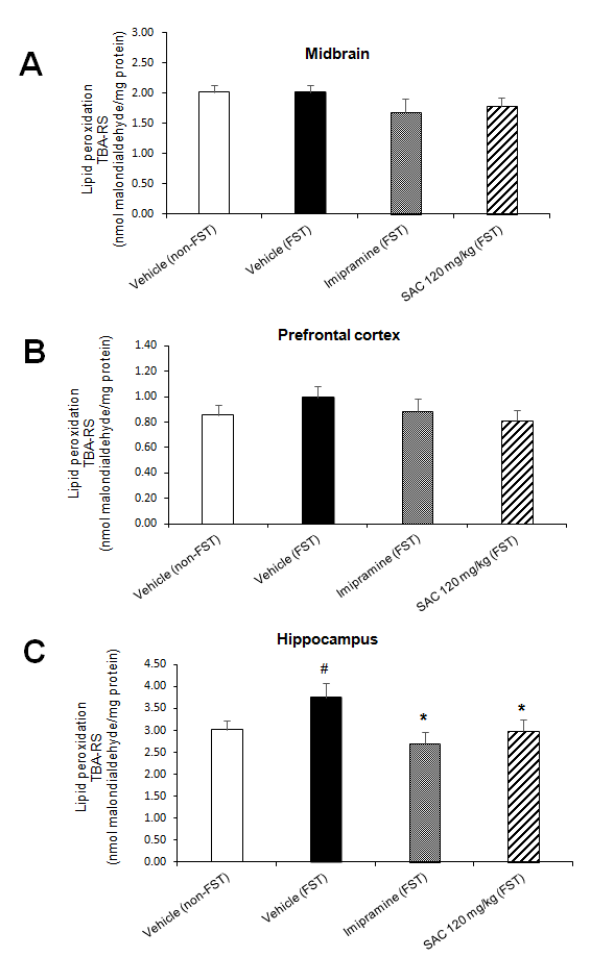
Figure 5. The antidepressant-like behavior of SAC is associated with a reduction in lipid peroxidation in the hippocampus of animals subjected to FST. The vehicle (non-FST or FST), imipramine (FST) or SAC (120 mg/kg) were the treatment groups. The thiobarbituric acid-reactive substances (TBA-RS) assay was used to measure lipid peroxidation in the midbrain ( A ), prefrontal cortex ( B ), and hippocampus ( C ). Results are expressed as mean ± SEM of 8 – 10 animals per group. The one-way ANOVA followed by post hoc Duncan’s tests was used to analyze the differences among groups. (#) Statistically different from vehicle non-FST group, p < 0.05, Duncan’s test; (*) statistically different from vehicle (FST) group, p < 0.05, Duncan´s test. FST = forced swimming test; SAC = S-allyl cysteine.